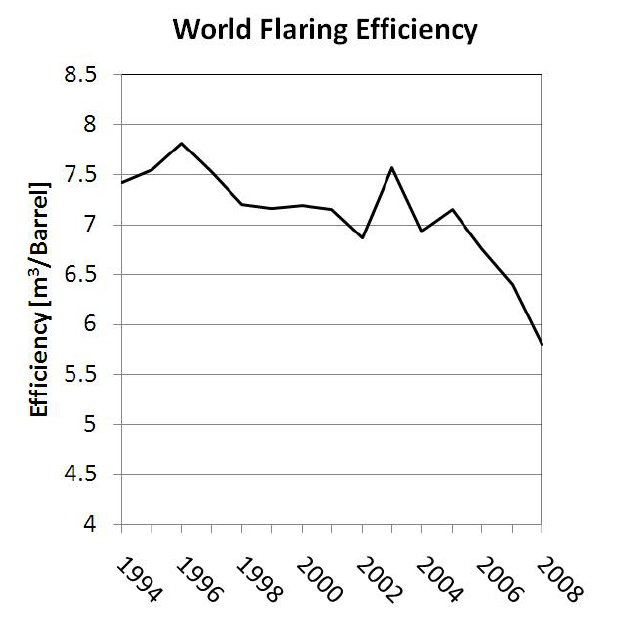
Figure 18. Global gas flaring efficiency ranged from seven to eight cubic meters per barrel of oil from 1994 to 2005. Since 2005 the efficiency has improved for three years in a row and stood at 5.6 m 3 per barrel in